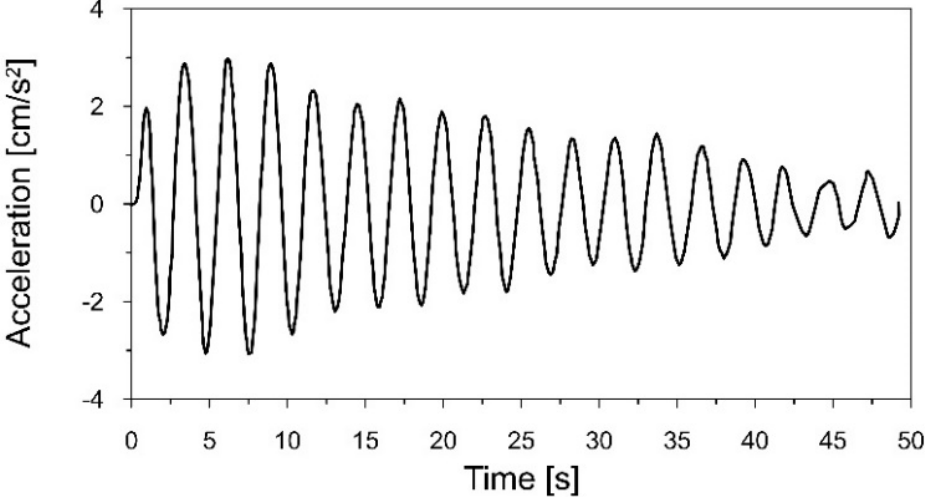
Figure 9. The acceleration − time history of the chimney vibration, induced by the movement of a group of people, registered at the level of the highest gallery (+117 m) in the X direction.